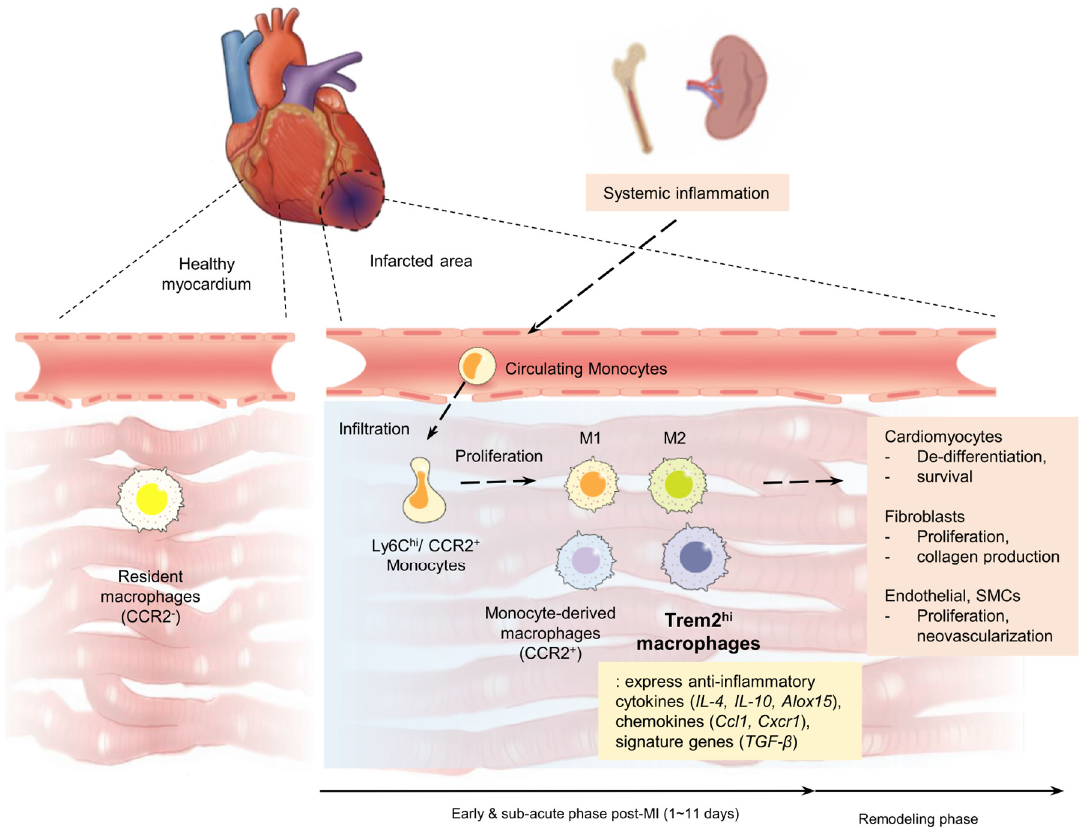
Figure 2. The contribution of circulating monocyte infiltration and monocyte-derived macrophages, as well as soluble Trem2 as a potential modulator of cardiac remodeling, in myocardial infarction. During a myocardial infarction, the bone marrow and spleen become instrumental in the delivery of monocytes that infiltrate the infarcted myocardium [43]. Upon arrival, these monocytes differentiate into macrophages and subsequently undergo proliferation. The infarcted myocardium recruits a significant number of leukocytes, including circulating inflammatory Ly-6C hi monocytes, which